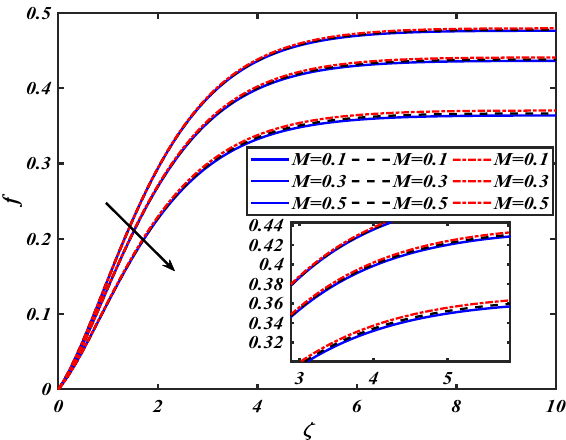
Figure 3. Pictogram of M via f .